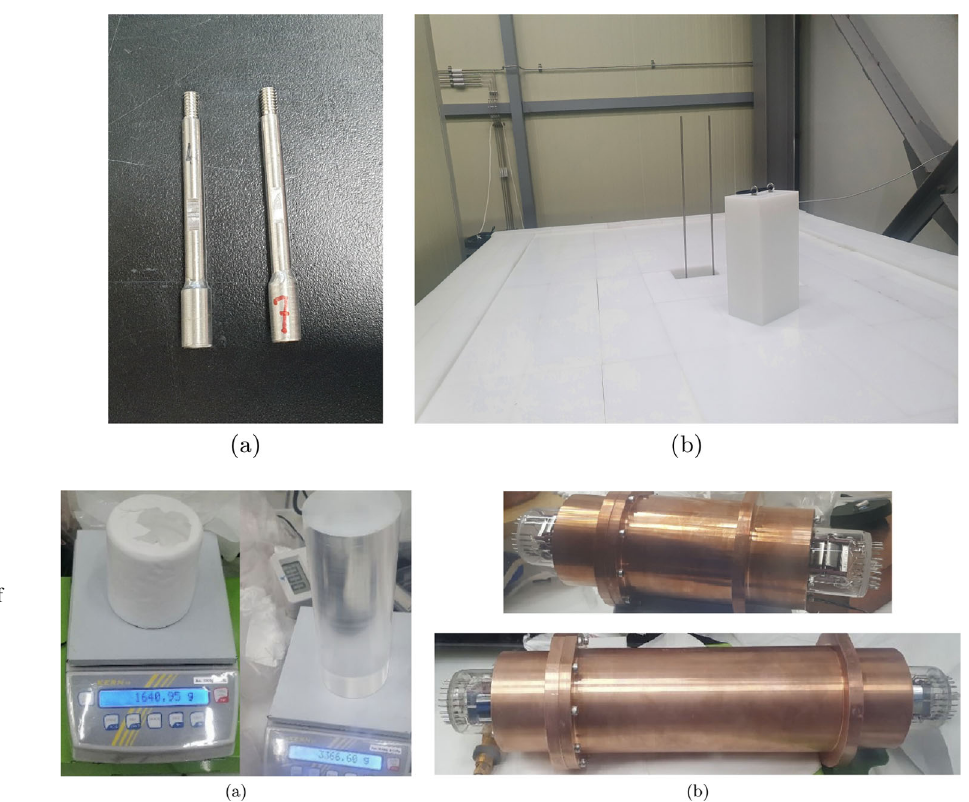
Fig. 6 NaI(Tl) crystals are polished manually with lapping films and encapsulated together with PMTs inside a copper encapsulation. a Bare crystals of 1.6kg and 3.7kg types are shown. b Completed detector assemblies are